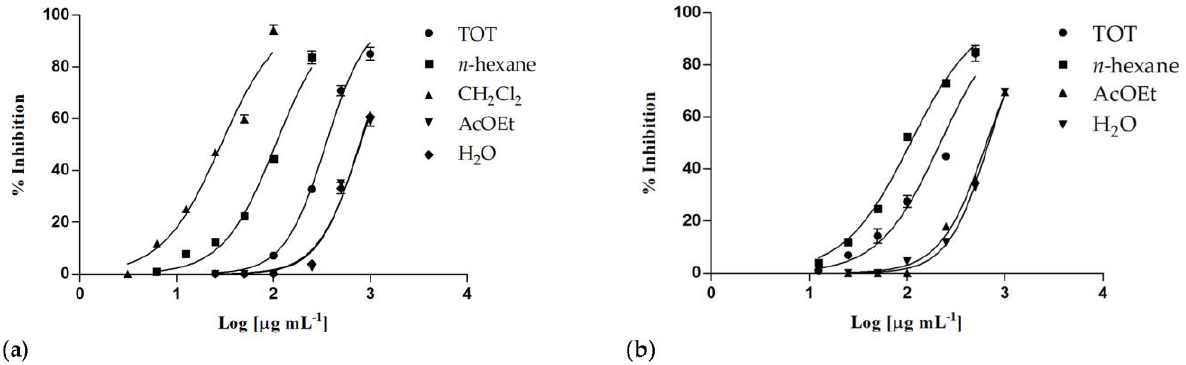
Figure 4. Nitric oxide production inhibition induced by ( a ) Centranthus ruber (L.) DC. and ( b ) Tropaeolum majus L. extracts and fractions. Data are expressed as mean ± S.E.M. (n = 4).